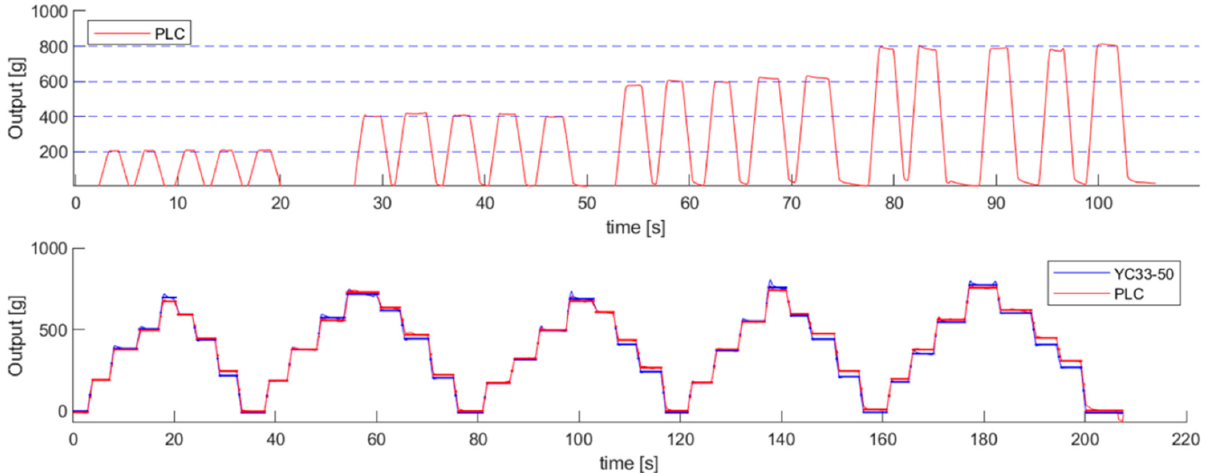
Figure 8. A successive loading test of the PLC compared with YC-33.